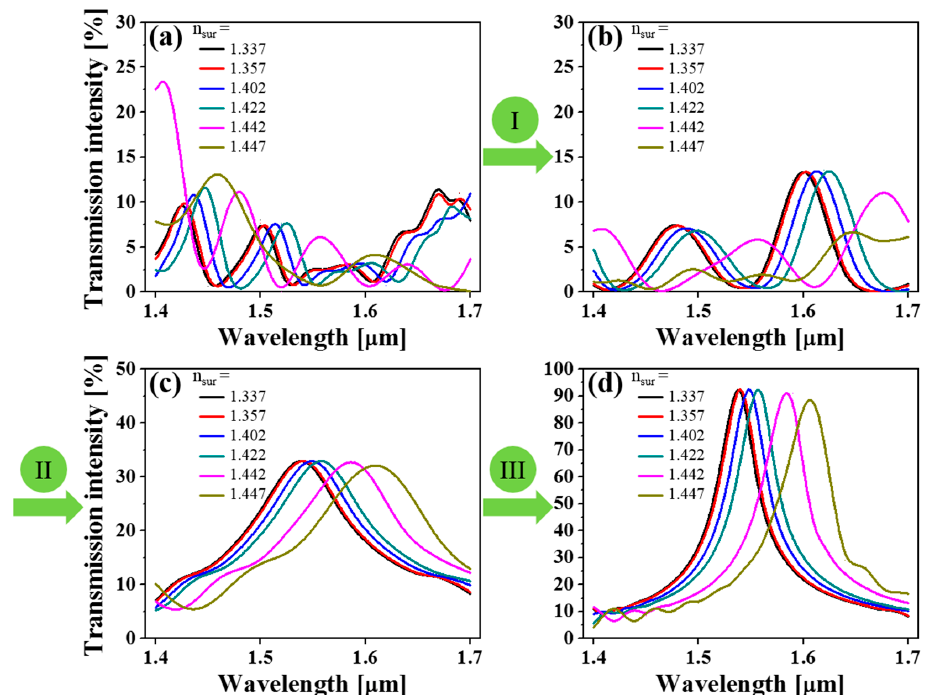
Figure A2. Transmission spectra for an MMI-based RI sensor under four different structural configurations. ( a ) The design incorporating a partly modified fiber core in width and L << L ’. ( b ) A fully modified fiber core for L << L ’. ( c ) A fully modified fiber core under a tenuous